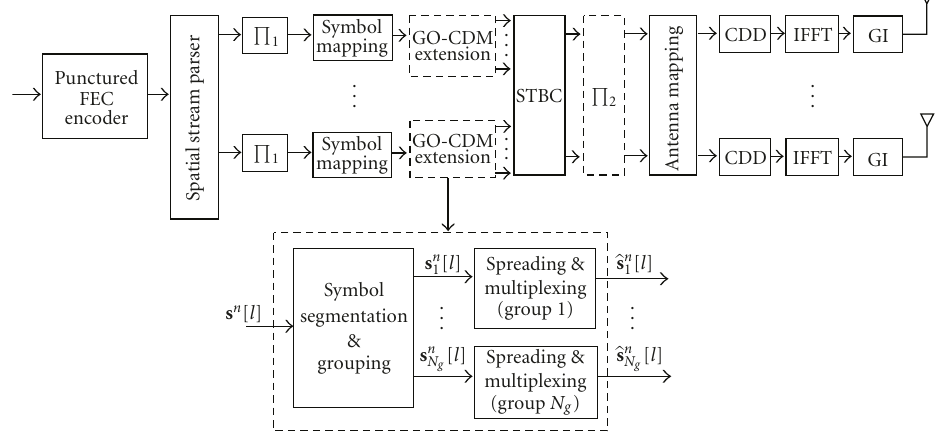
Figure 1: IEEE 802.11n transmitter (elements drawn using dashed lines belong to the GO-CDM extension). (see Section 3), the symbols on each stream, after serial- to-parallel conversion, are optionally supplied to an STBC encoder following the Alamouti coding rule [3]. An impor- tant point to mention here is that STBC takes place on a per subcarrier basis and between two successive OFDM